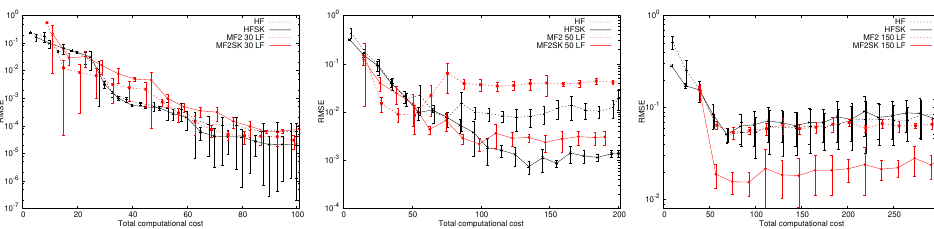
Figure 16. Kriging: ALOS function RMSE (from left to right, one, two and three dimensions). Ordinary and SPCE-Kriging in dashed and solid lines, respectively.